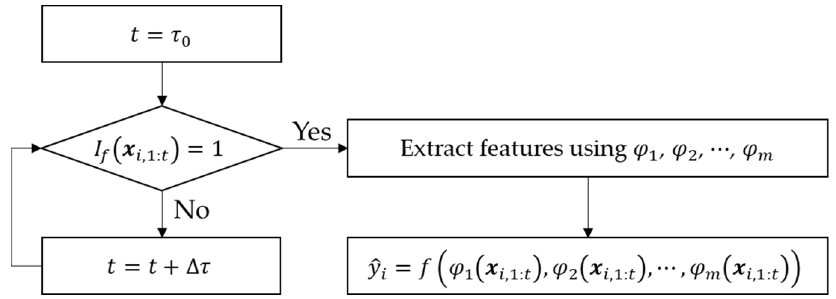
Figure 3. Early classification process using the proposed indicator and a classifier.